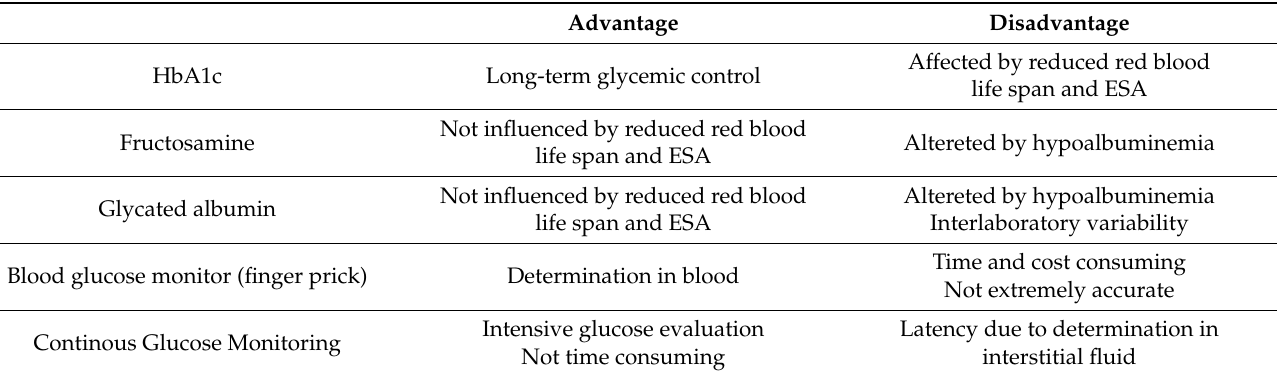
Affected by reduced red blood life span and ESA Altereted by hypoalbuminemia Altereted by hypoalbuminemia Interlaboratory variability Time and cost consuming Not extremely accurate Latency due to determination in interstitial